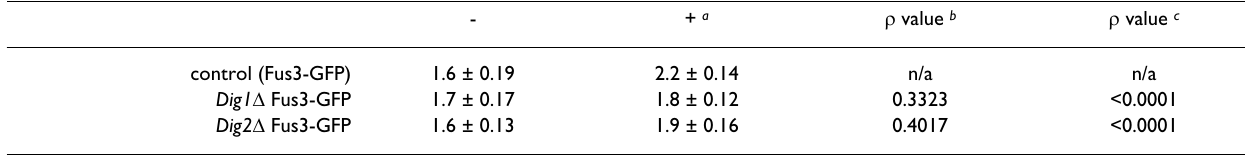
Table 1: RNCF and ρ values